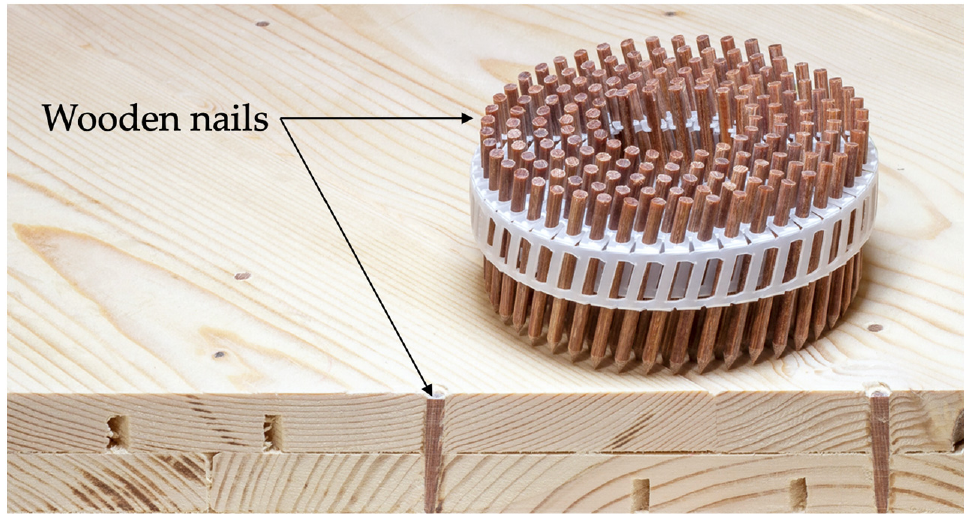
Figure 17. LIGNOLOC ® wooden nails [129].